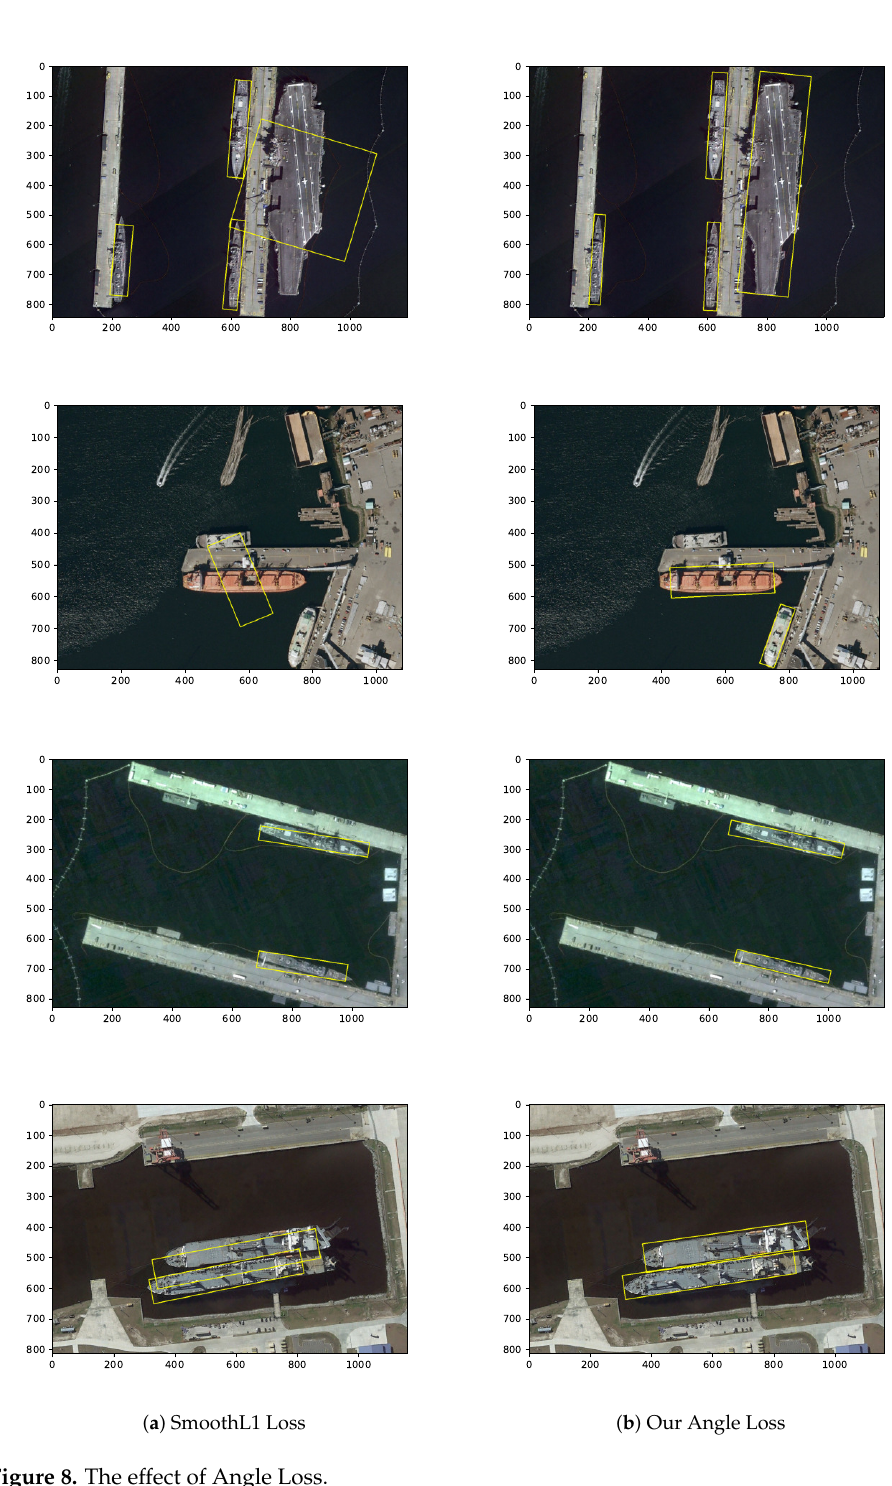
Figure 8. The effect of Angle